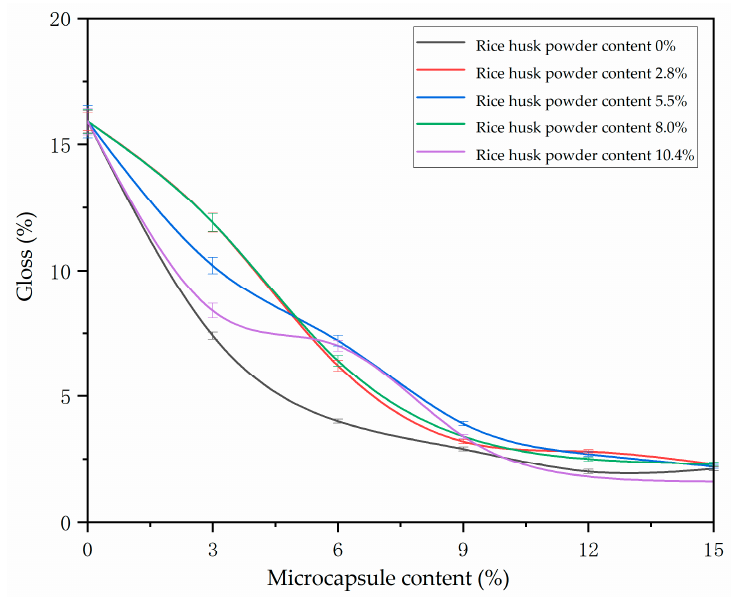
Figure 7. Effect of microcapsules with different wall material ratios on the gloss of waterborne primer coating. Table 9. Effect of microcapsule addition on the hardness of waterborne primer